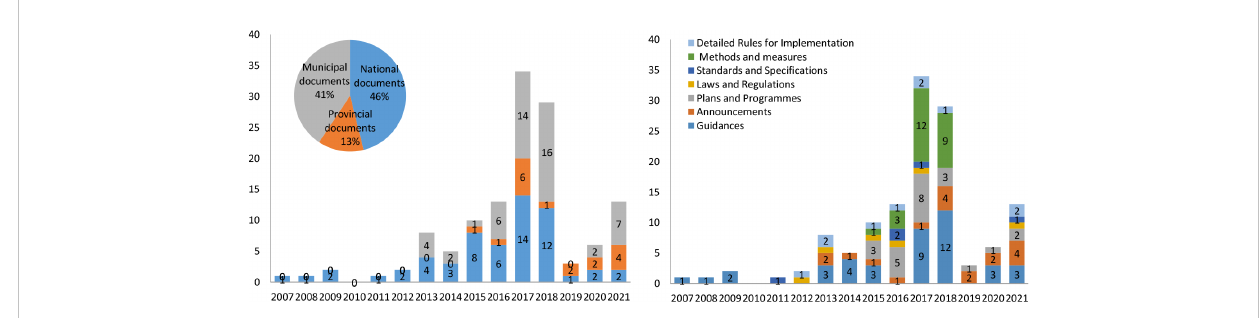
FIGURE 7 Types of released policies. Note: The fi gure on the left shows statistics of policies issued by administrative bodies at different levels; The fi gure on the right shows the statistics of the number of different policy